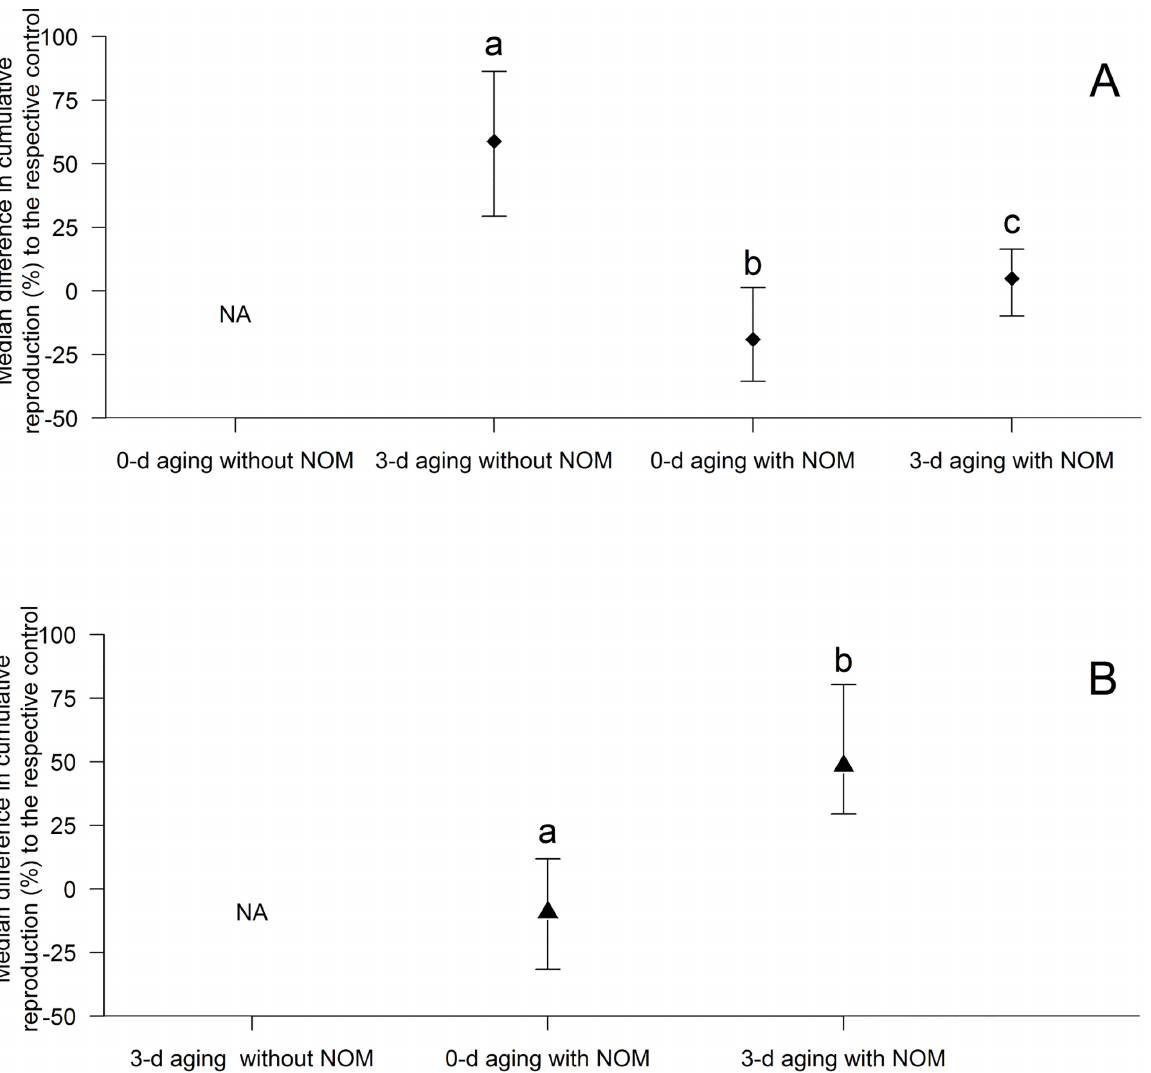
Fig 3. Fecundity of Daphnia . Median difference in the reproduction of Daphnia ( ± 95% CI) after 21 d of exposure to (A) 2.0 and (B) 6.0 mg nTiO 2 /L expressed relative to the respective control containing 0.0 mg/L nTiO 2 . Higher numbers indicate a decreased cumulative reproduction compared to the control. NA = not assessed due to 100% mortality in the nTiO 2 treatment. Values followed by different lower case letters denote a statistically significant difference.